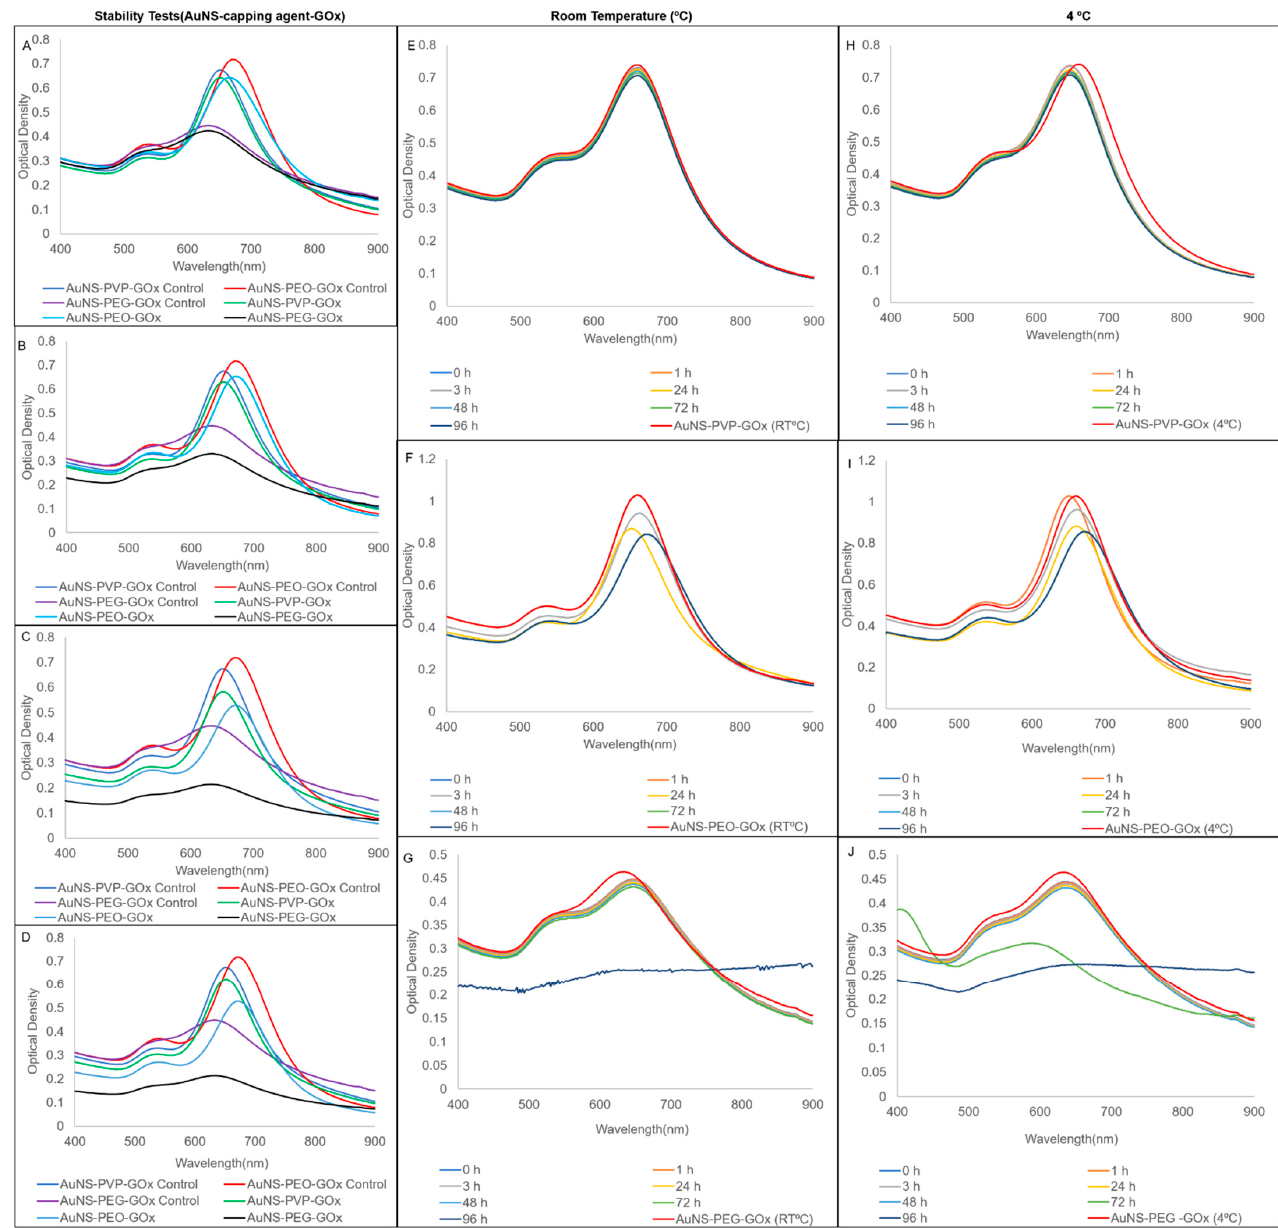
Figure 4. UV-vis spectra of stability comparisons for AuNSs bioconjugated with glucose oxidase after 3 h of incubation in ( A ) salt; ( B ) urine; ( C ) serum; and ( D ) supplemented cell culture media. Storage stability UV-vis spectra at room temperature and 4 °C, respectively, for ( E , H ) AuNS-PVP-GOx; ( F , I ) AuNS-PEO-GOx; and ( G , J ) AuNS-PEG-GOx.